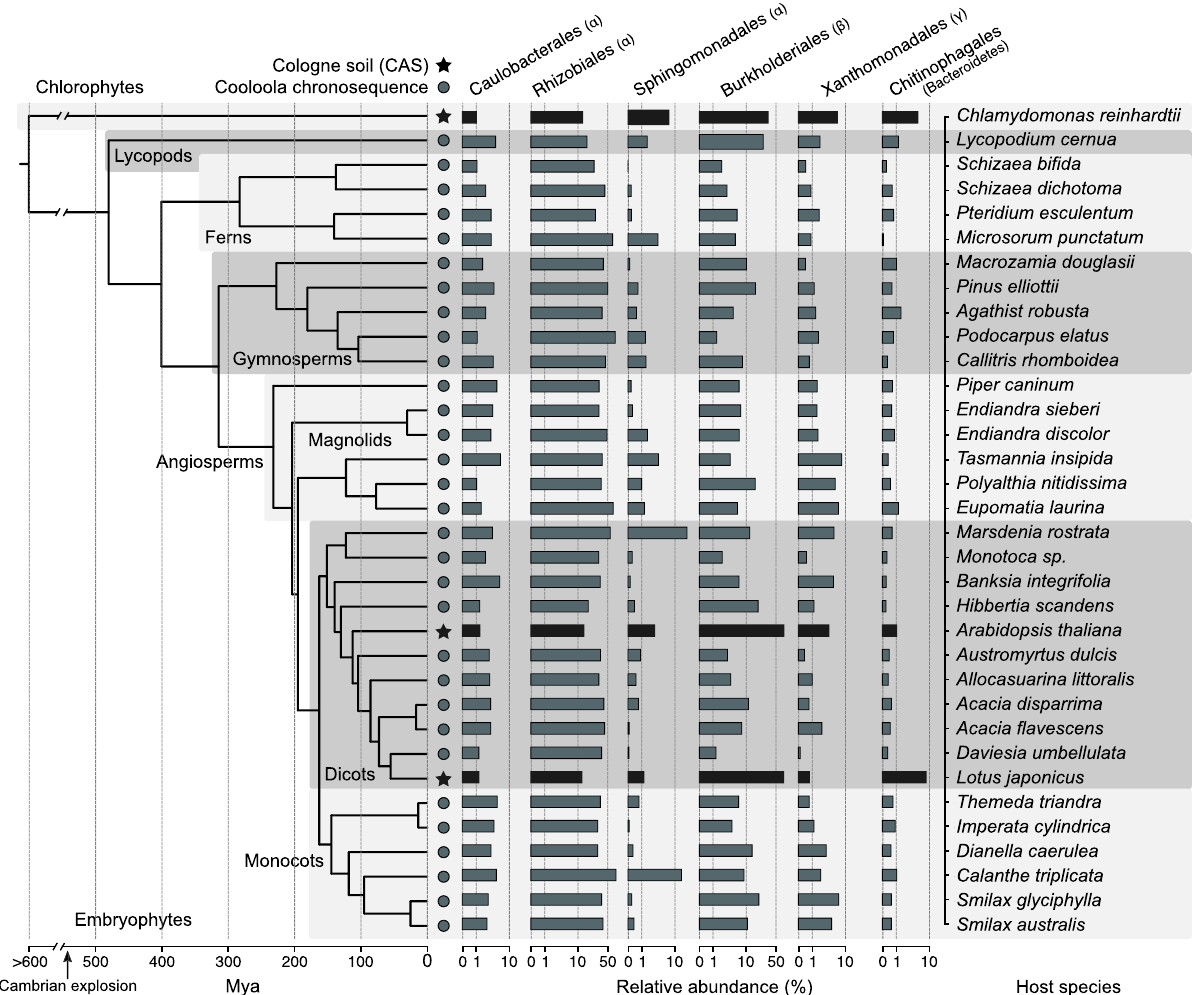
Fig. 2 Conservation of bacterial orders of the root and phycosphere microbiota across photosynthetic organisms. Phylogeny was inferred from a multiple sequence alignment of the ribulose-bisphosphate carboxylase gene ( rbcL ) of 35 plant species and Chlamydomonas reinhardtii . The bar plots represent the average aggregated relative abundance of the six bacterial orders found to be present in the root microbiota of each plant species (80% occupancy and ≥ 0.1% average relative abundance). Leaf nodes depicted with a star symbol denote community pro fi les of plants grown in CAS soil in the greenhouse 7,43 , whereas those marked with a circle were obtained from plants sampled at the Cooloola natural site chronosequence 11 . Includes data for At and Cr from experiment A (Supplementary Fig. 1a and Supplementary Table